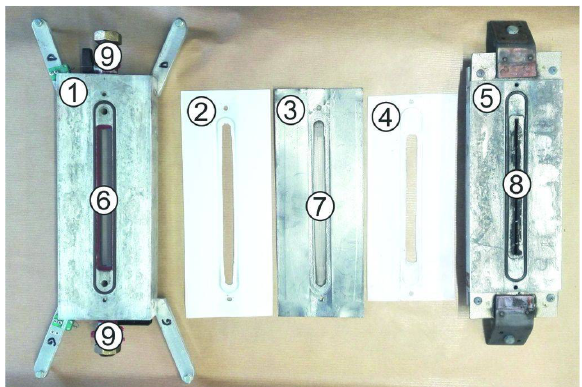
Fig. 2. The image of the test section with the minichannel: 1-front cover, 2, 4-Teflon plate, 3-graphite plate, 5-channel body, 6- glass panel, 7-heated plate, 8-micanite plate, 9-thermocouple.